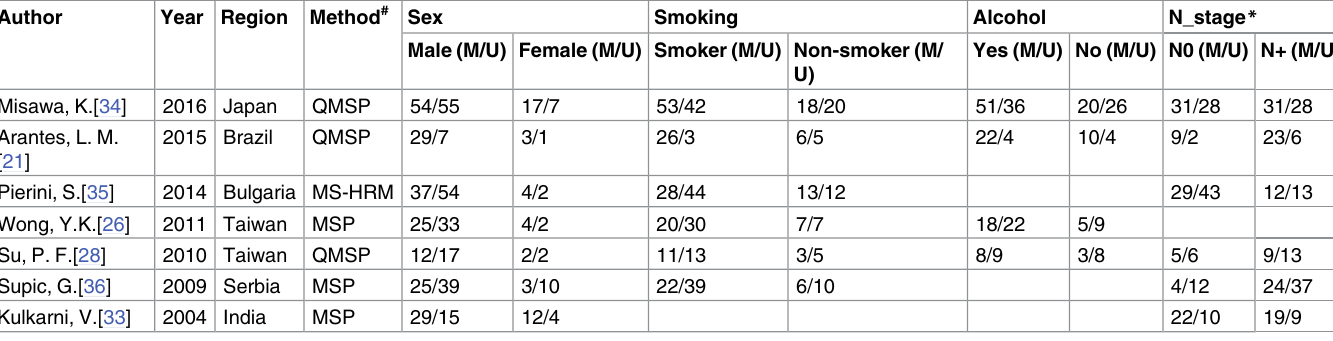
Table 2. Characteristics of studies included in themeta-analysis of DAPK promoter methylation and clinicopathological features.